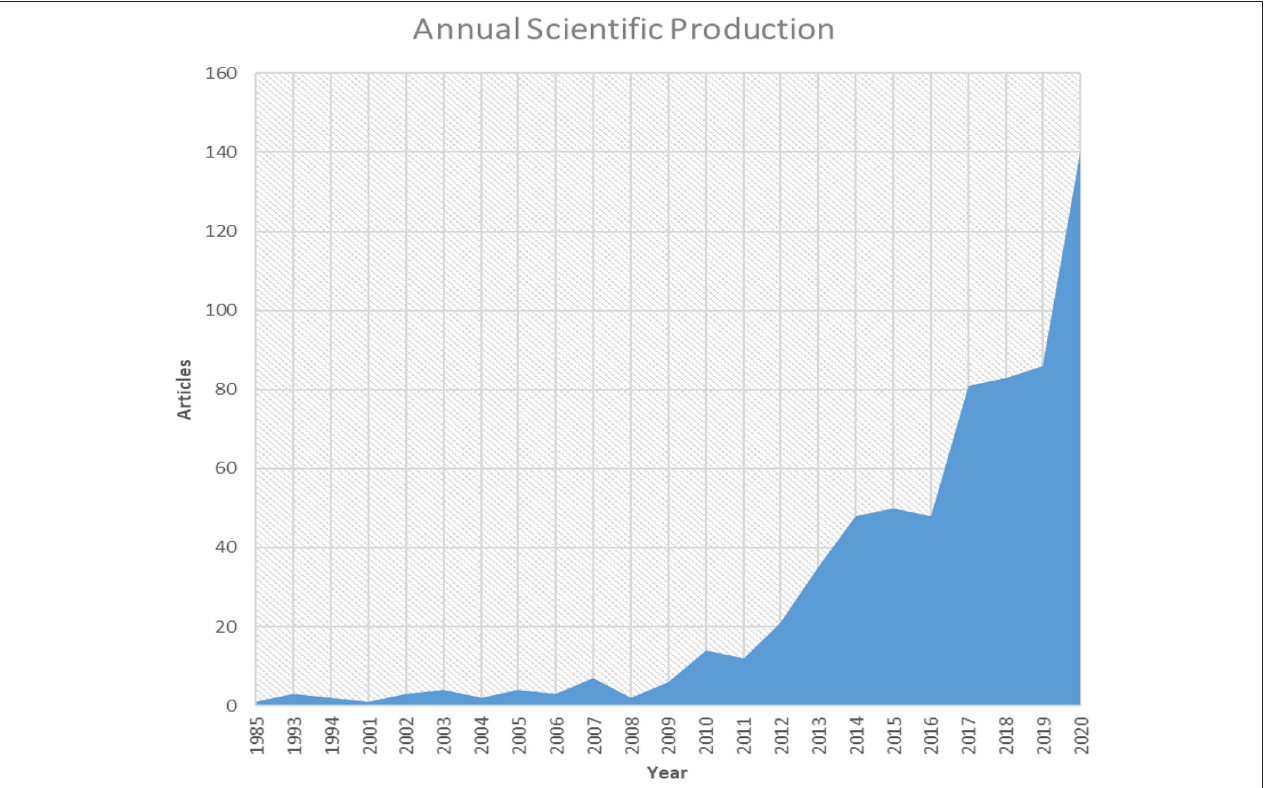
FIGURE 3 | Trend of annual scientific production of research outputs (from 1985 to 2020) in the field of nanotechnology and meat production with an annual growth rate of 25.18%. Meat production studies with the use of nanotechnology show slight fluctuations of research outputs between 1985 and 2008.